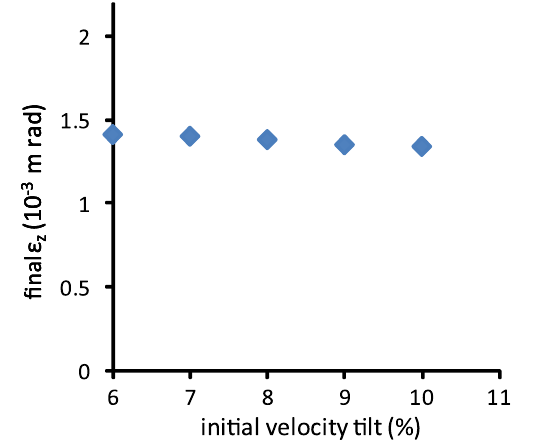
FIG. 13. Final z emittance at z ¼ 60 m ( (cid:1) 10 (cid:2) 3 ) vs initial velocity tilt.